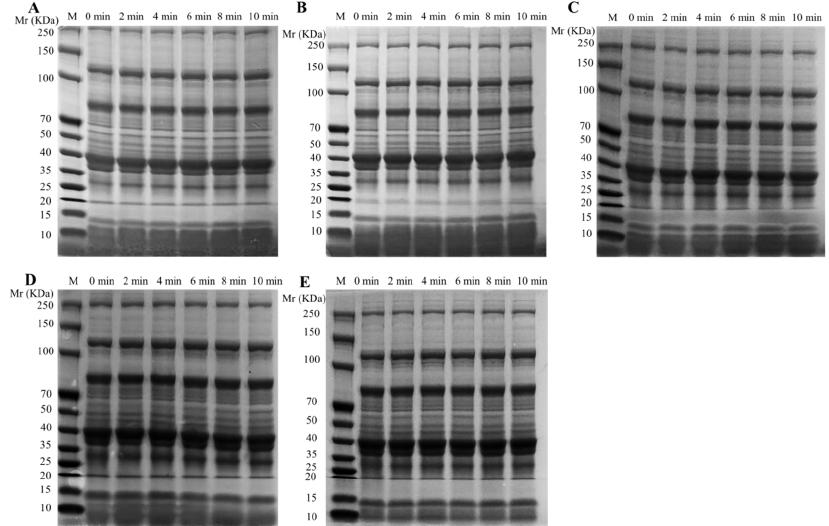
Figure 5. The effect of different heating treatment conditions on the SDS-PAGE of LWE. ( A ): heating treatment at 55 °C; ( B ): heating treatment at 58 °C; ( C ): heating treatment at 61 °C; ( D ): heating treatment at 64 °C; ( E ): heating treatment at 67 °C.